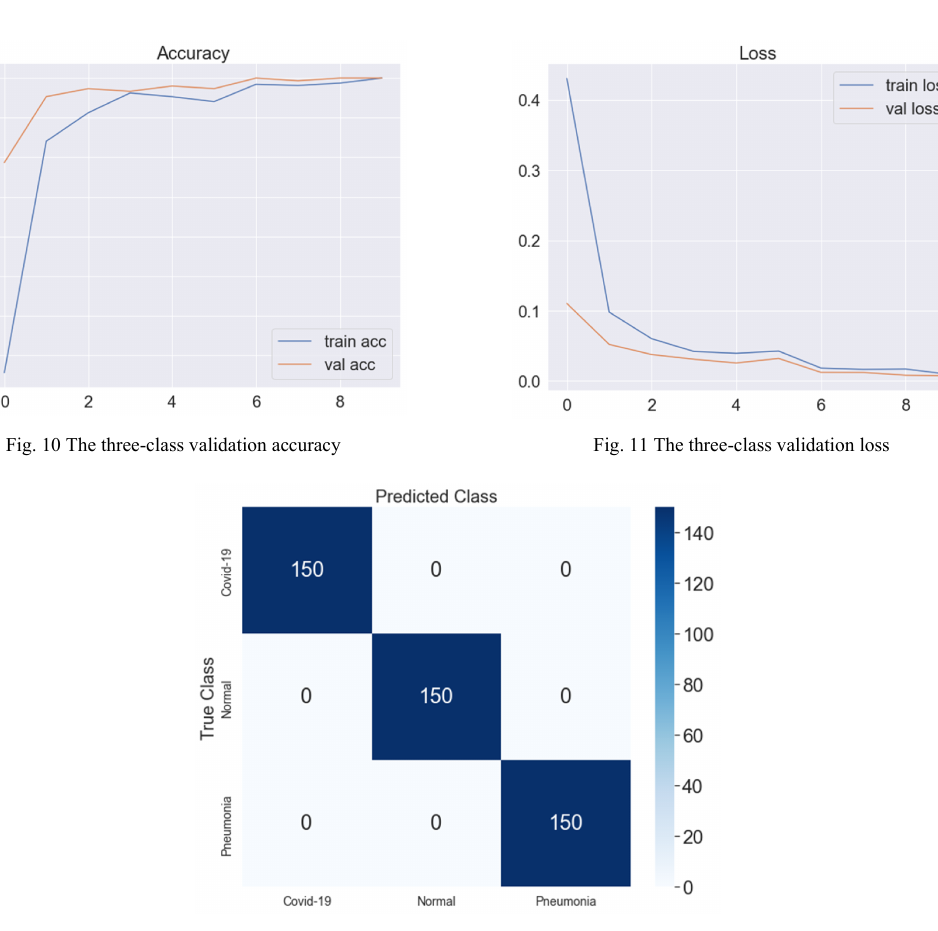
Fig. 12 Validation three-class loss